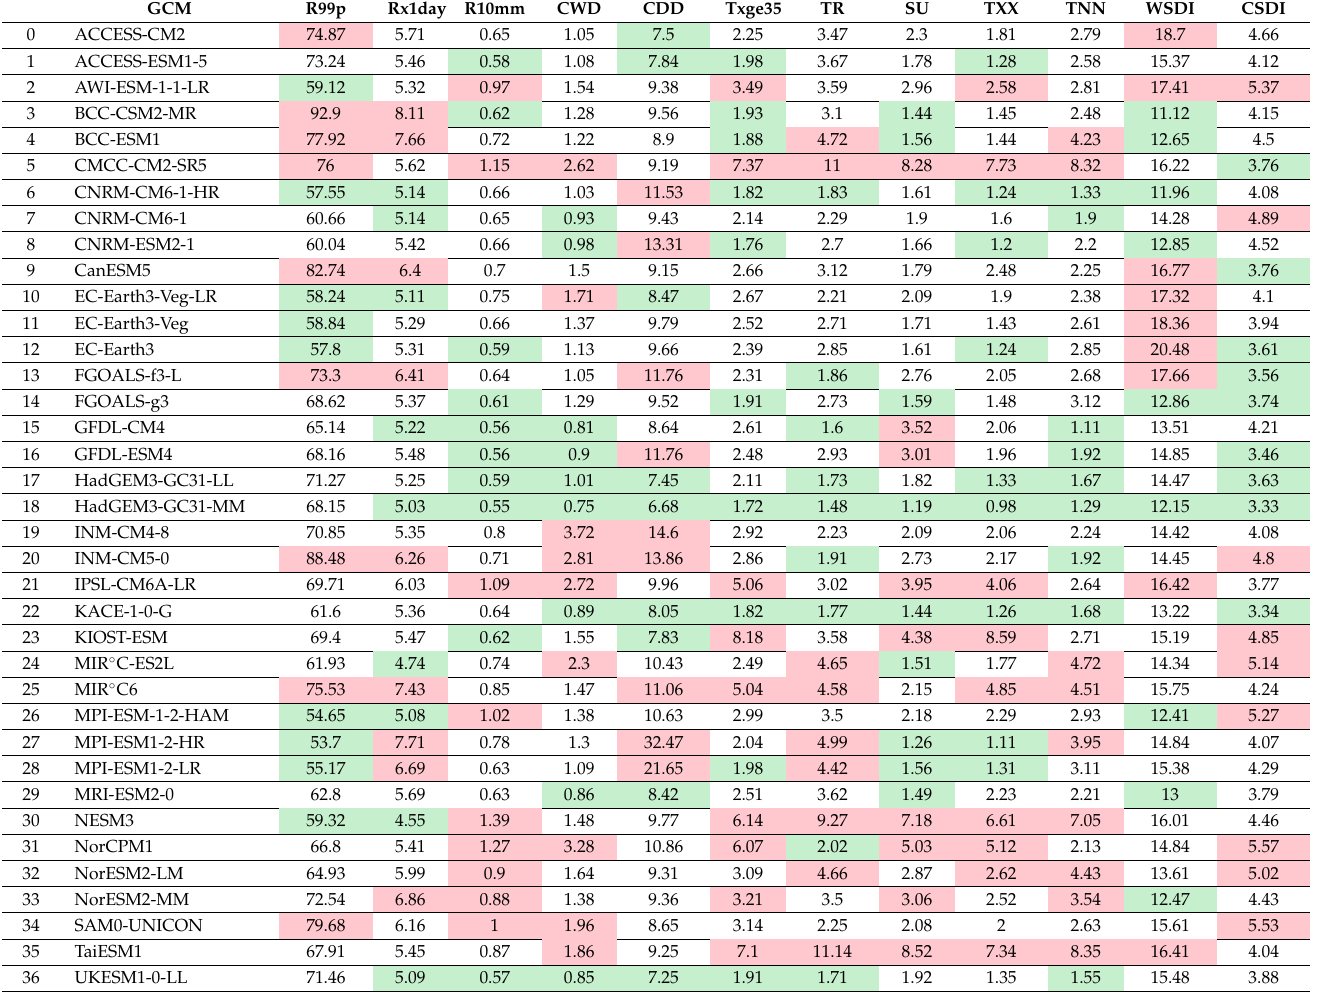
Table 4. Table of continentally averaged root mean square error (RMSE) recorded in 37 CMIP6 GCMs for the 12 extreme indices. A smaller value of RMSE corresponds to the better performance of GCMs. Here, the colour green and red denote the best (top 25% subset) and worst (bottom 25% subset) performing